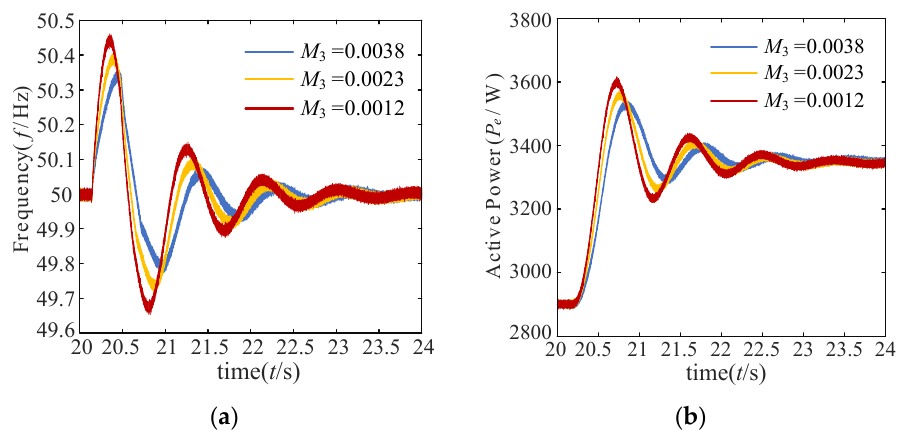
Figure 12. The influence of control parameter M 3 variations on the system: ( a ) System frequency waveforms; ( b ) Output waveforms active power.